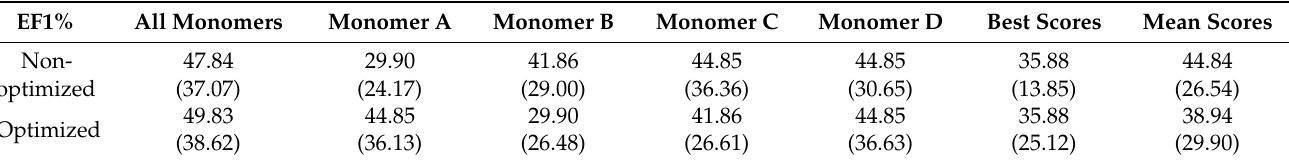
Table 6. Best performances as derived from consensus analysis of multiple non-optimized